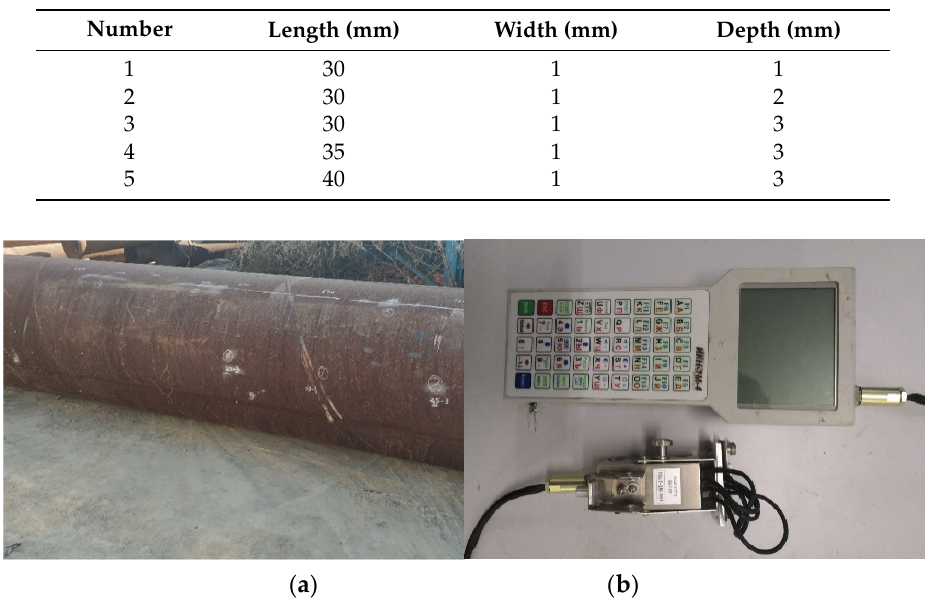
Figure 13. The experimental pipeline and weak magnetic detection device: ( a ) the experiment pipeline and ( b ) the weak magnetic detection device.